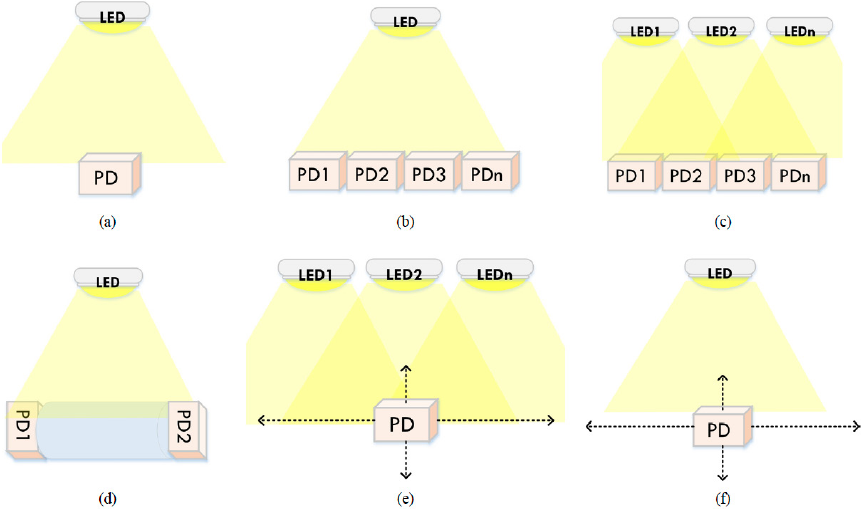
Fig. 1. Signal transferred through visible light with various scenarios: (a) Single transmitter and receiver in LOS configuration with fixed setting [13] ; (b) fixed setting of single transmitter and array-photodiode to increase FOV [14] ; (c) fixed setting of multi- transmitter and multi-photodiode, generally used for MIMO VLC scheme [15] ; (d) higher FOV with fixed setting method based double receiver and single transmitter us- ing fluorescent concentrator which is proposed by [16] ; (e) movable setting using multi- transmitter and single photodiode, typically this configuration is used for indoor